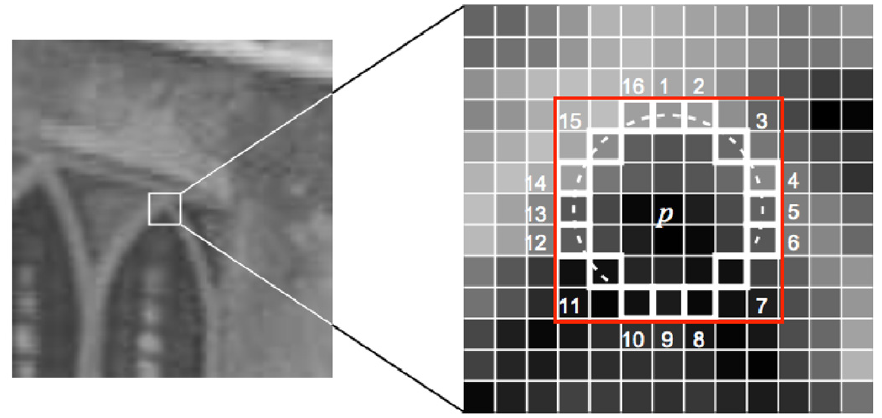
Figure 4. Schematic of FAST key point detection.